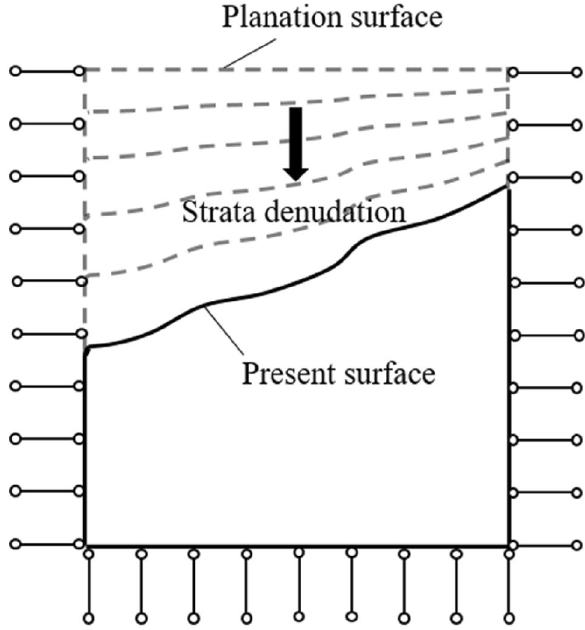
Figure 1. Schematic diagram of ancient strata denudation